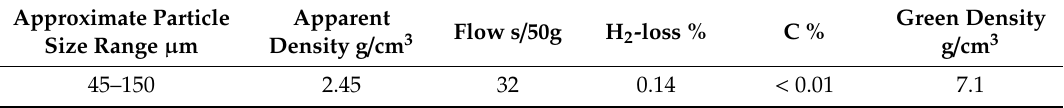
Table 1. SC 100.40 iron powder.